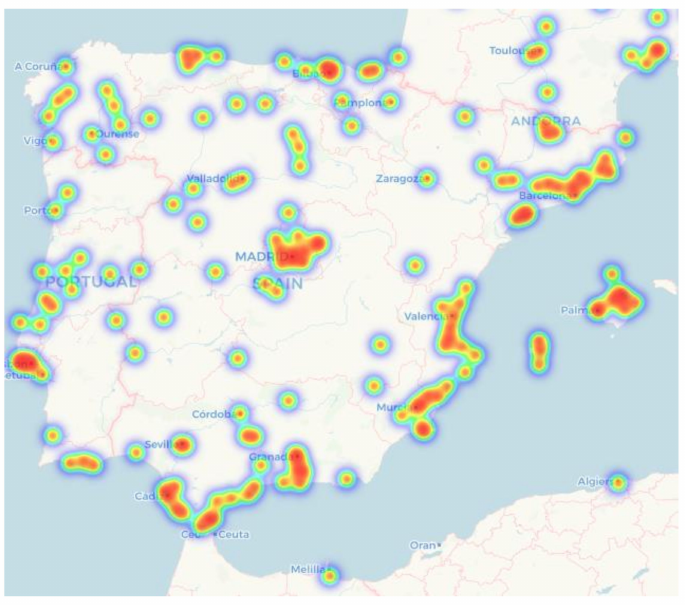
Figure 3. Spanish map of businesses which accept Bitcoin. Source: Coinmap.org.